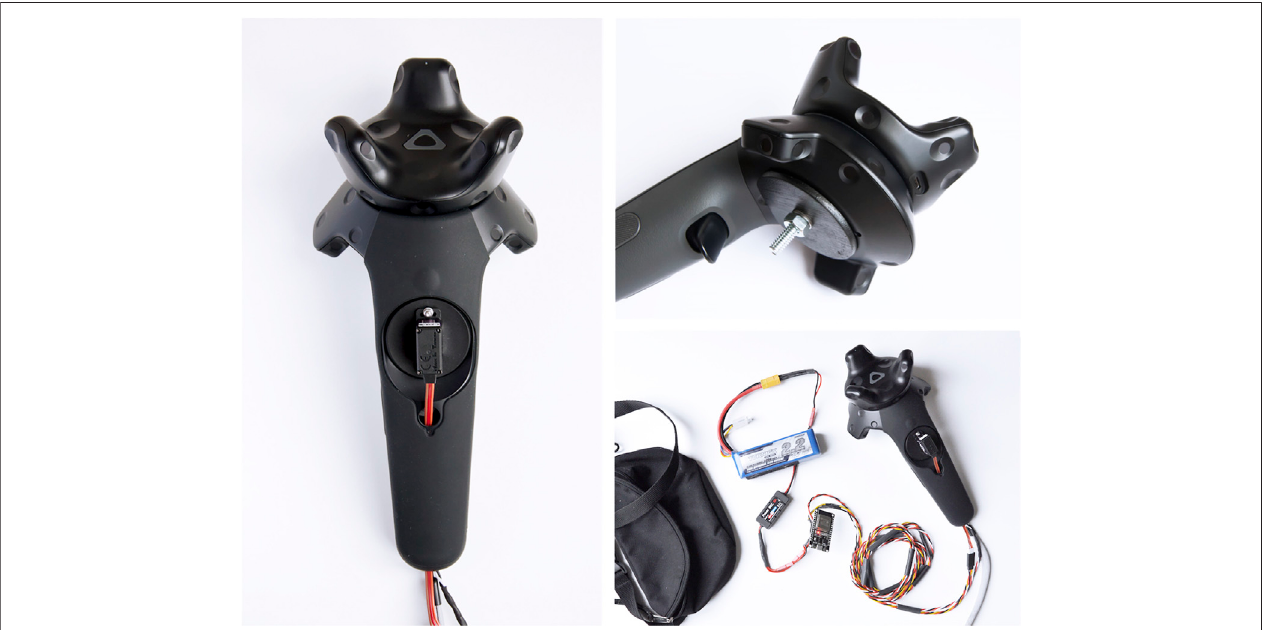
FIGURE 7 | (left) Our haptic VR controller Triggermuscle. (top right) Attachment of the HTC Vive tracker to enable spatial tracking. (right bottom) Electronic components (MCU, the battery and the BEC) are carried in a small bag.